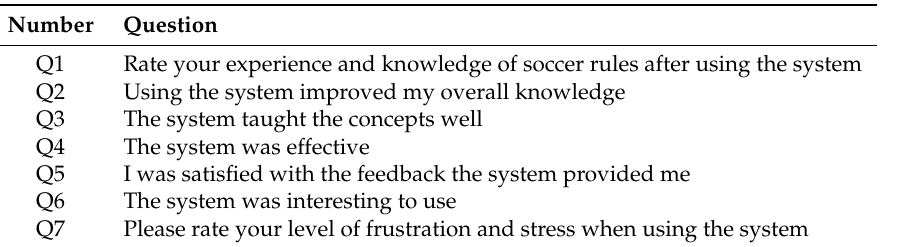
Table 2. Qualitative questions asked during the Post Questionnaire.